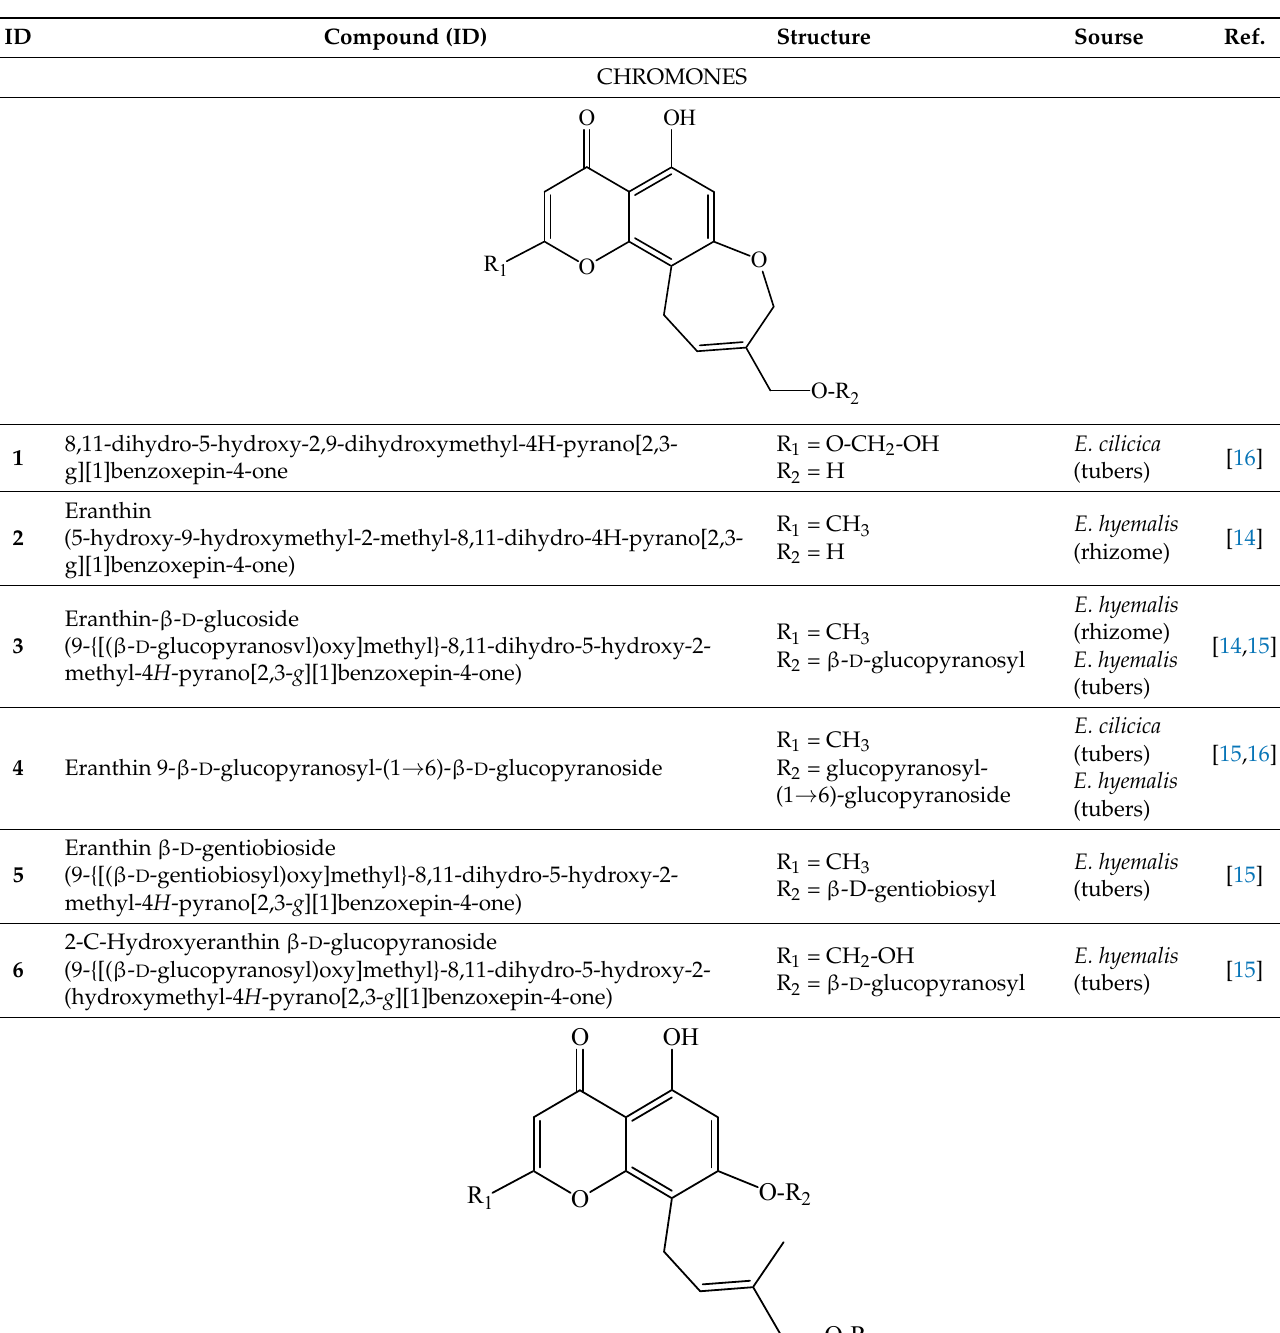
Table 2. Chromones that were previously found in Eranthis species.